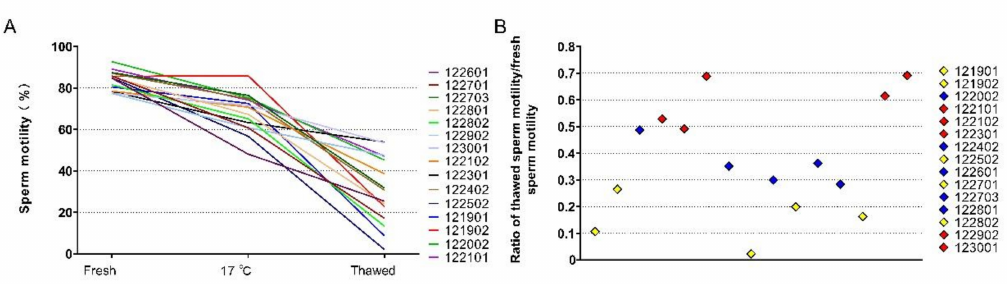
Figure 1. Screening semen for differential freezability. ( A ) sperm motility during freezing and after thawed, ( B ) relative sperm motility, ratio of thawed sperm motility/fresh sperm